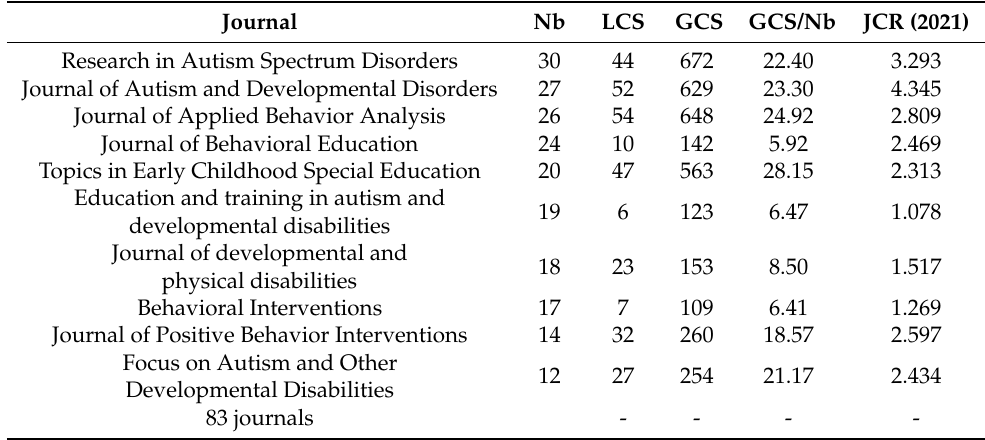
Table 5. Journals by the number of publications and citations received (LCS and GCS) and Impact Factor (JCR).